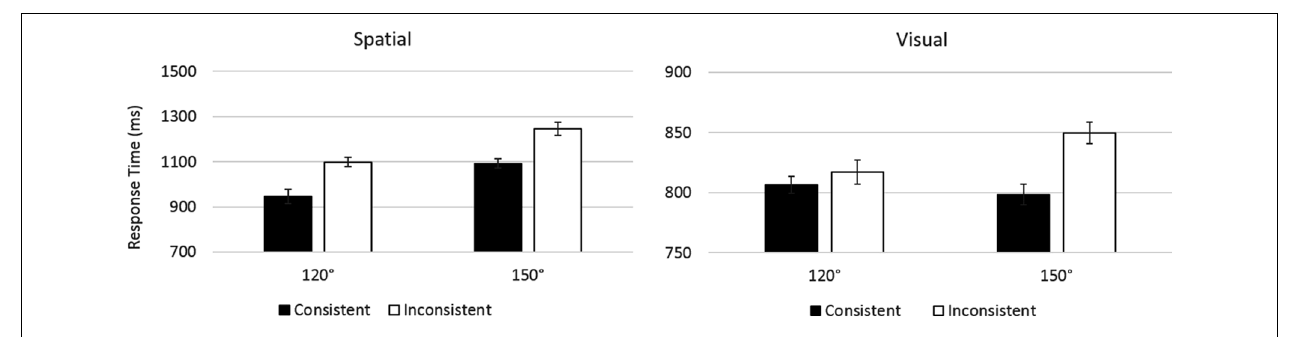
FIGURE 5 | Results of Experiment 2. Error bars show within-subjects standard error of the mean.The effect of Consistency is greater for Spatial perspective-taking.There was no interaction between Angle and